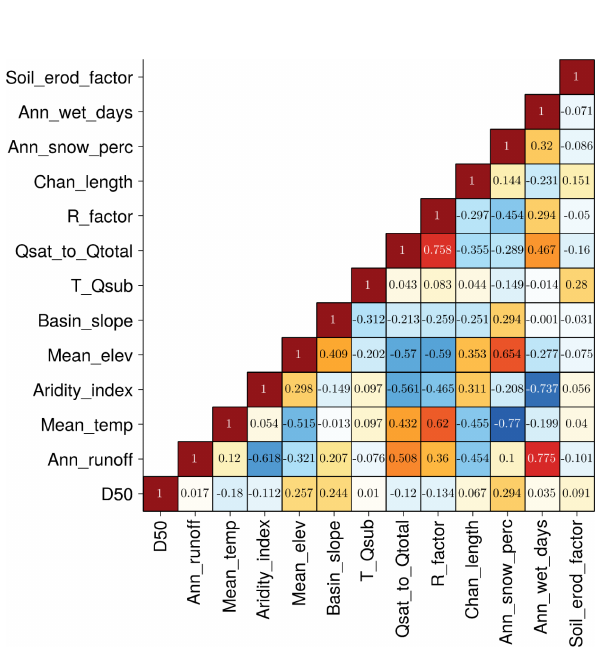
Figure 4. Correlation coefficients among D50 and the 12 selected